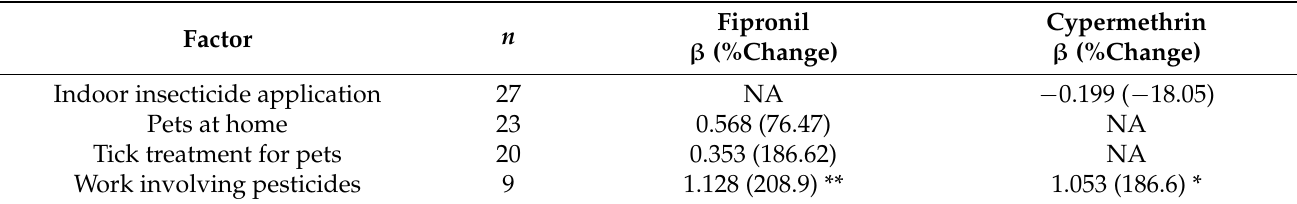
Table 3. Associations between indoor pesticide concentrations and questionnaire responses by multivariate linear regression analysis ( n =